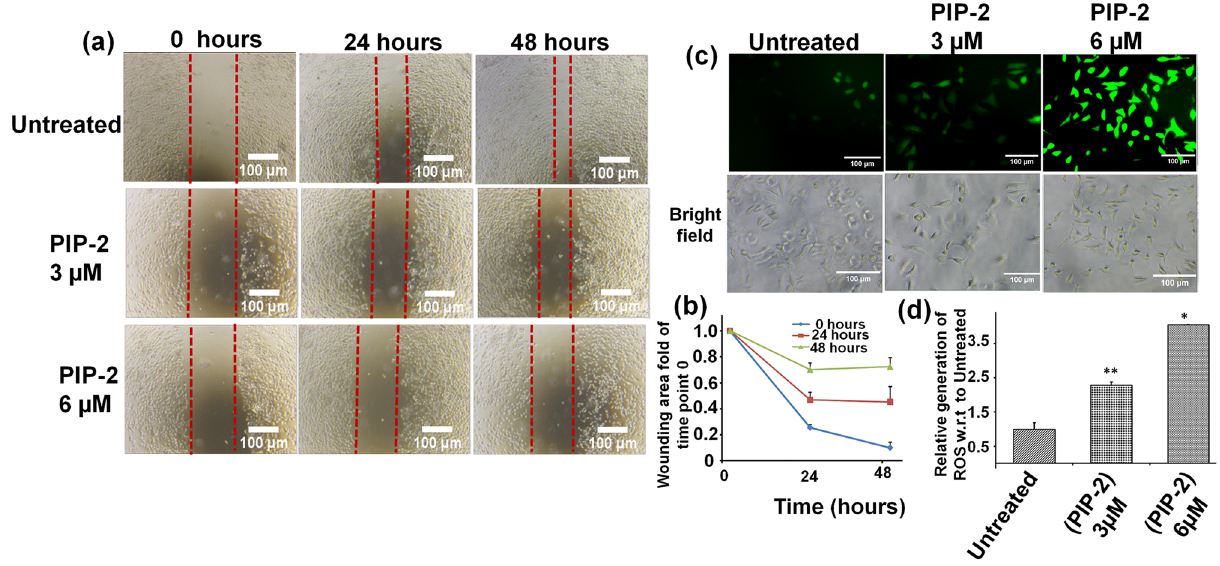
Figure 10. Wound healing assay showed migration speed is decreased in the PIP-2 treated A549 cells. ( a , b ) The bright-field images represent the migration speed of A549 cells in both PIP-2 treated and untreated cells. ( b ) The bar graph represents the wound closure area expressed as the area that remained uncovered by the cells. The wound (scratch) area at 0 h time point was set as 1. The results are the average of three different sets of experiments and collected values expressed as means ± SD. ( c ) Reactive oxygen species (ROS) generation assay in A549 cells untreated (control), 3 µM, and 6 µM PIP-2 treatment for 24 h. Images were taken using a fluorescence microscope. Scale bar 100 µm. ( d ) Quantification of ROS in the untreated and PIP-2 treated cells. The statistical significance derived from the Student’s t-test (*P < 0.05, **P < 0.01, ***P < 0.001) by analyzing the control (untreated) group is indicated by the asterisks. 100 µm scale